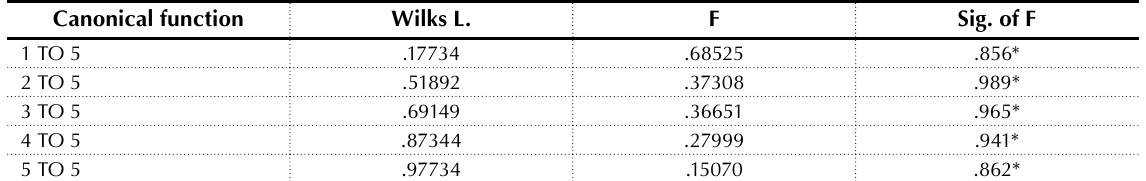
Table 19. Dimension reduction analysis